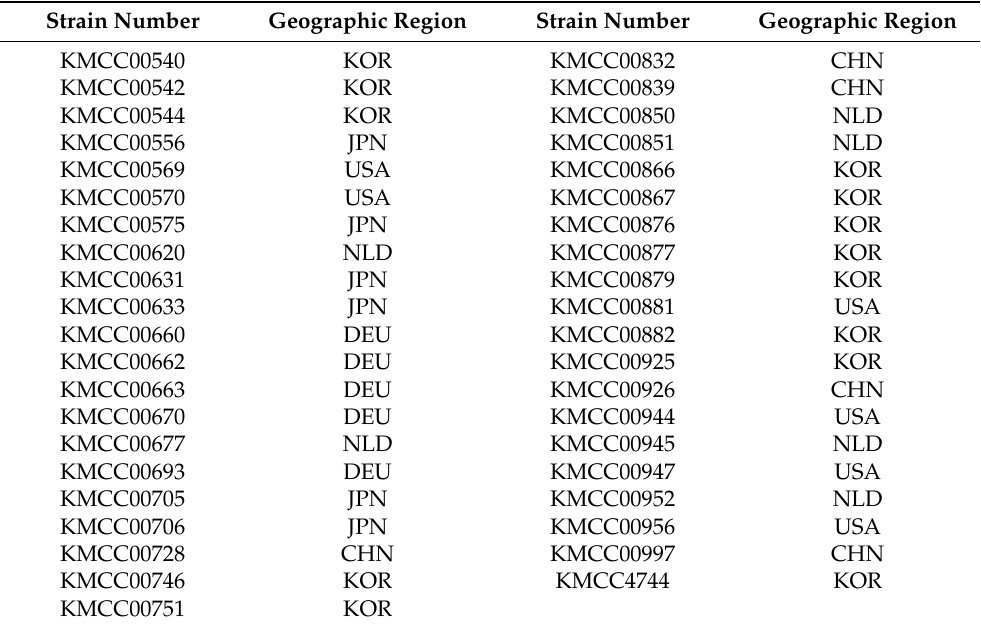
Table 1. A. bisporus accessions used for validation of CAPS markers. Strain Number Geographic Region Strain Number Geographic Region KMCC00540 KOR KMCC00832